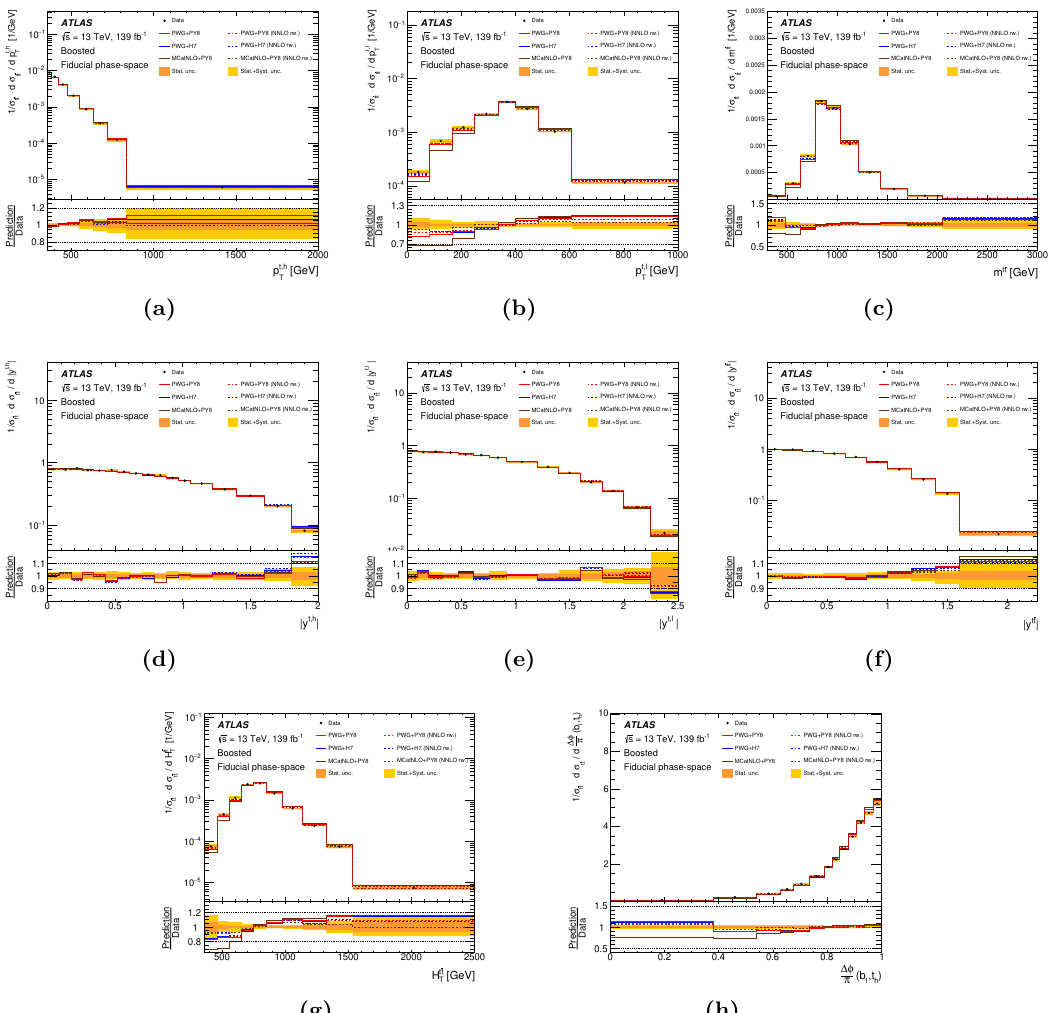
Figure 23. Normalised differential cross-section measurements for the observables related to the kinematics of the top quarks. The cross-section is shown as a function of (a) p t,h , (b) p t,‘ , (c) T T ¯ t , (d) ¯ t ¯ t and (h) ∆ φ ( b ) . In each plot the data are compared m t | y t,h | , (e) | y t,‘ | , (f) | y t | , (g) H t , t ‘ h T with predictions from the NLO generators with and without the NNLO reweighting. PWG+PY8 corresponds to the Powheg+Pythia sample, PWG+H7 to the Powheg+Herwig sample and MCatNLO+PY8 to the MadGraph5_aMC@NLO+Pythia sample. The orange band shows the size of the statistical uncertainty and the yellow band shows the size of the total uncertainty. The lower panel in each subfigure displays the ratios of the different predictions to the